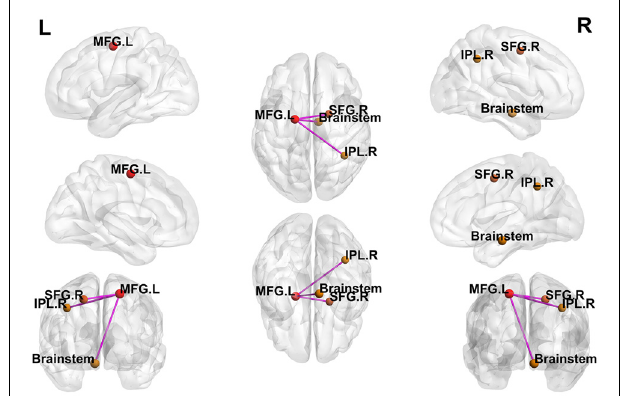
FIGURE 4 | Differences in whole-brain FC between patients with active-stage UC and HCs. The peak level threshold was set to p = 0.001, and the cluster level FDR-corrected threshold was set to p < 0.05. The purple node represents the seed point; all FC strengths were